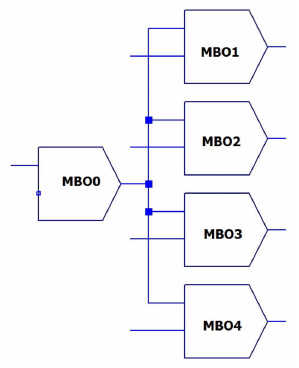
Figure 7. Block diagram of the coupled oscillator